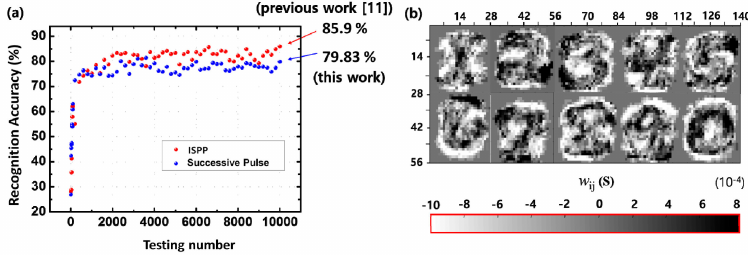
Figure 7. Modified National Institute of Standards and Technology (MNIST) pattern recognition result. ( a ) Recognition accuracy comparison between a successive-pulse programming and the ISPP; ( b ) Synaptic weight map after training 10,000 samples with the ISPP